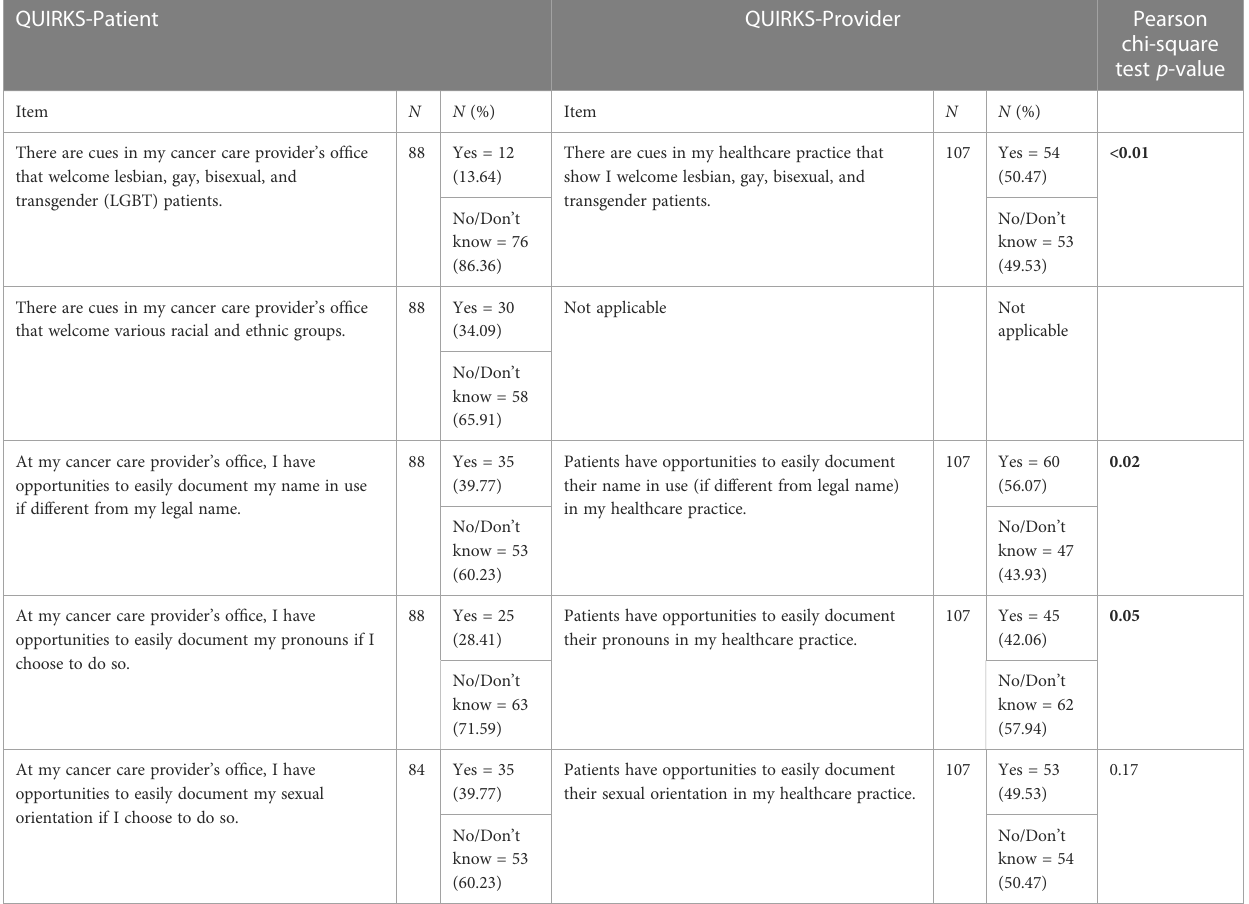
TABLE 3 Patient and provider reported experiences of environmental cues for LGBTQI-af fi rming care.